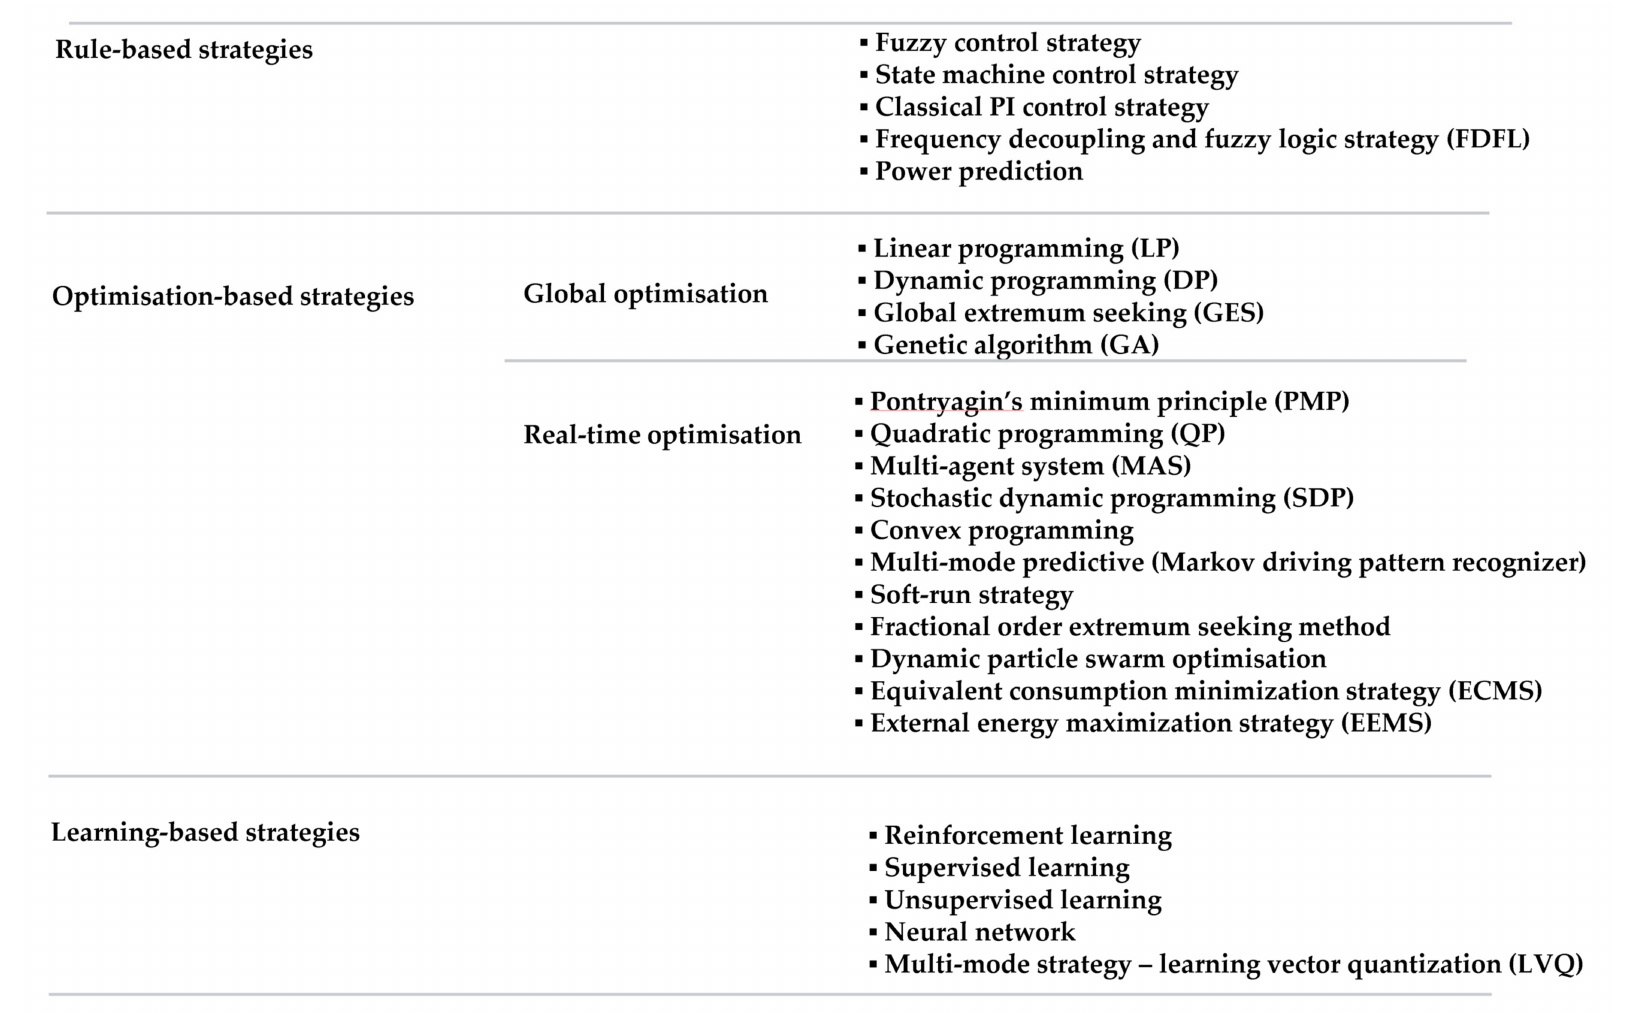
Figure 6. Classifications of the energy management strategies